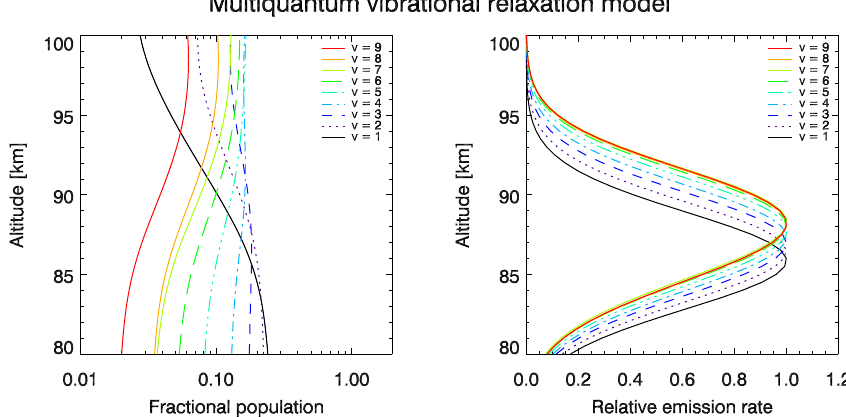
Fig. 8. Same as in Fig. 6, except that quenching by atomic oxygen is modelled using the O-quenching rate constant taken from Smith et al. (2010) in combination with the correction factor ( β =1.293) from Xu et al. (2012). Adjusted O 2 -quenching is also taken from Xu et al. (2012), but is found to have only minor impact on the model results.